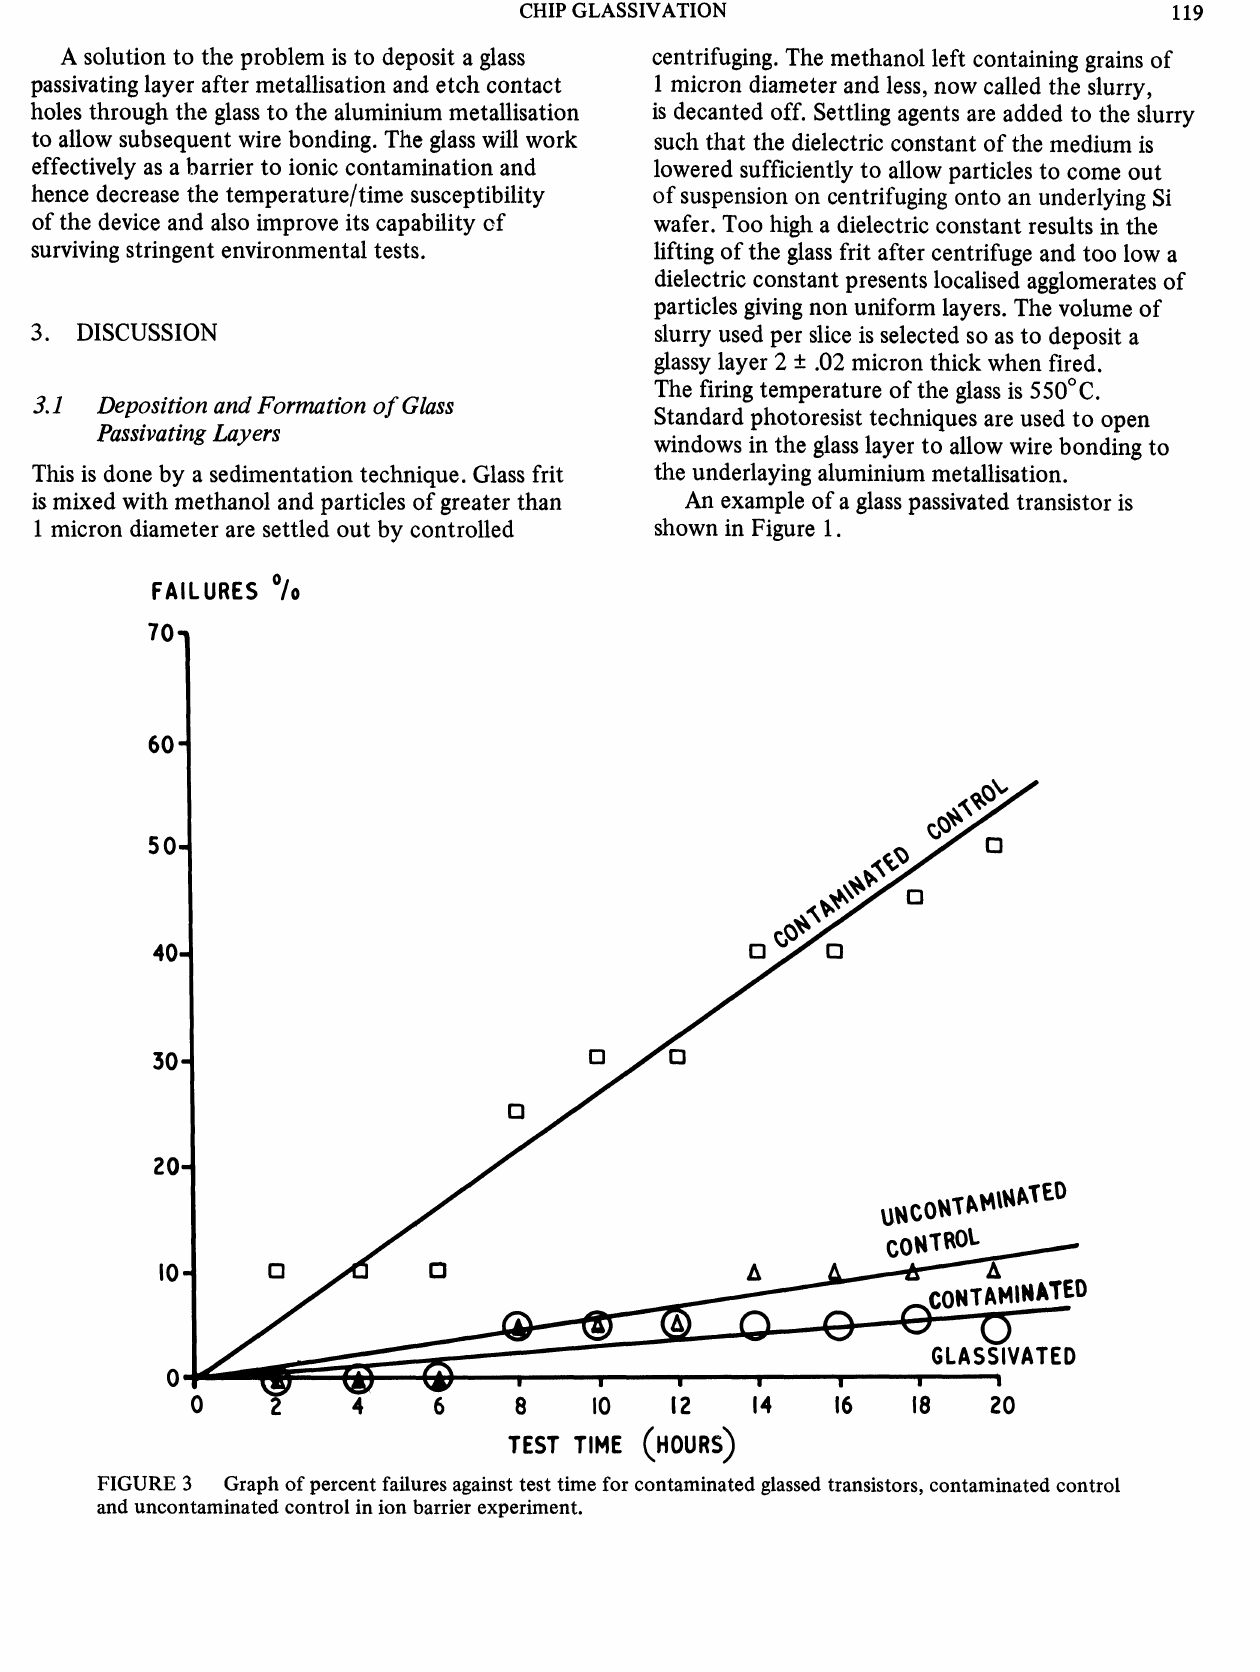
Graph of percent failures against test time for contaminated glassed transistors, contaminated control and uncontaminated control in ion barrier